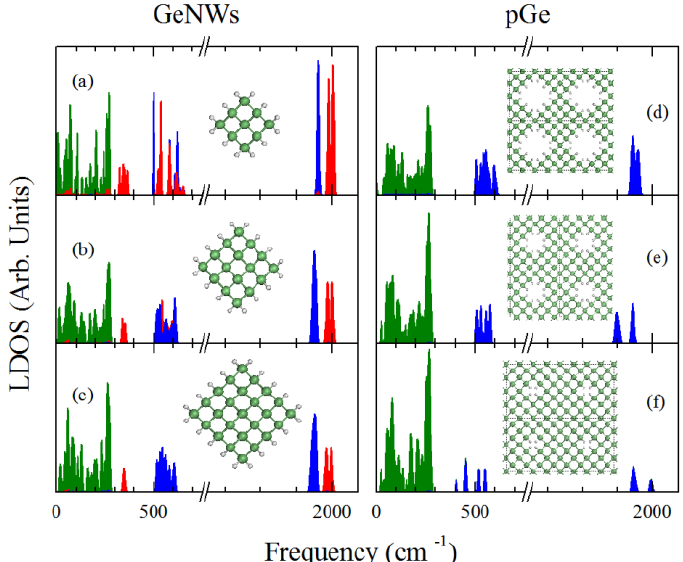
Figure 5. GeNWs vibration modes of ( a ) single hydride bending mode ( scissor-bending mode (